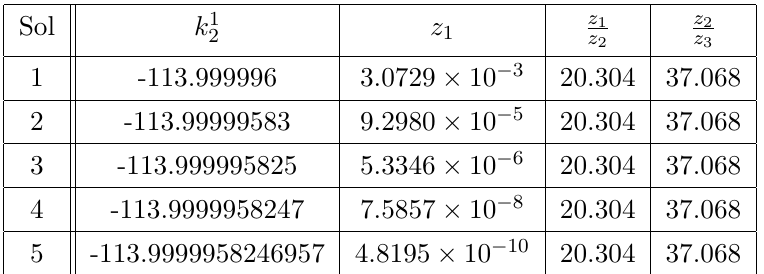
Table 3 . Scaling process of the solution with one supertube and three Gibbons-Hawking centers with parametrically-large aspect